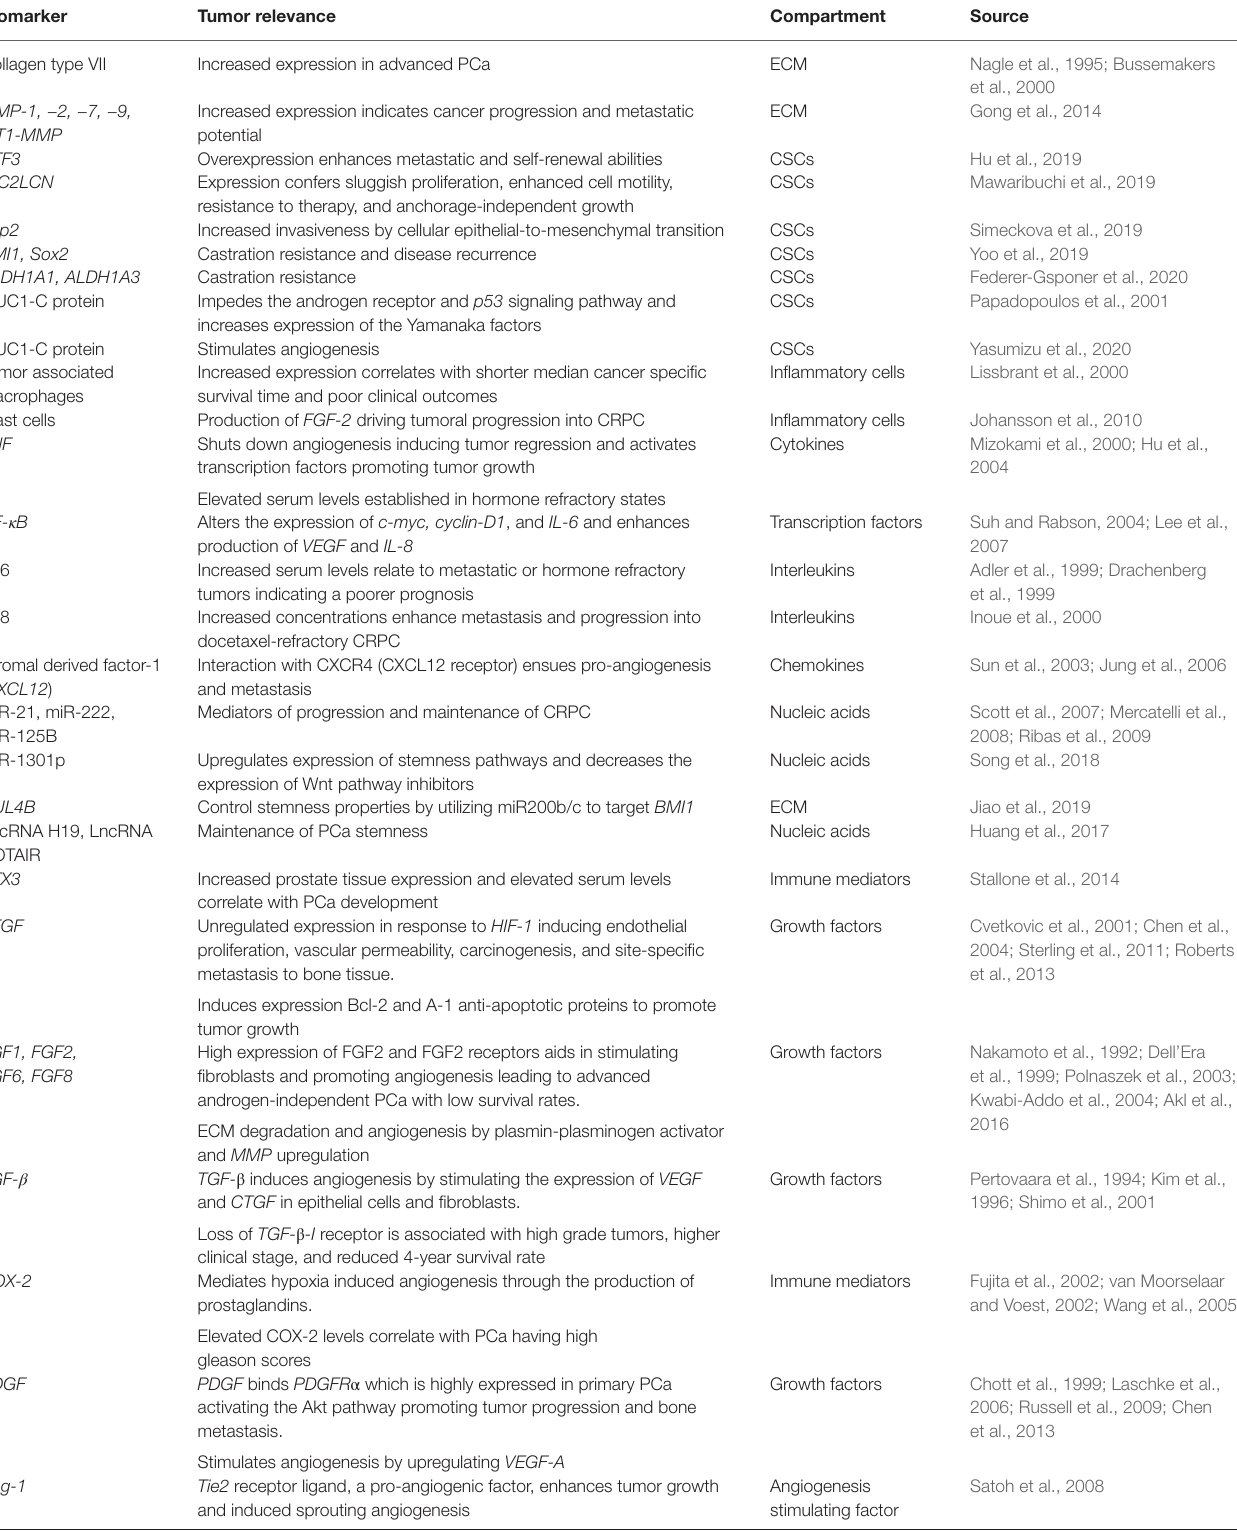
TABLE 1 | Table summarizing relevant molecular biomarkers pertaining to the tumor microenvironment and their role in diagnosis, prognosis, and therapy development in prostate cancer